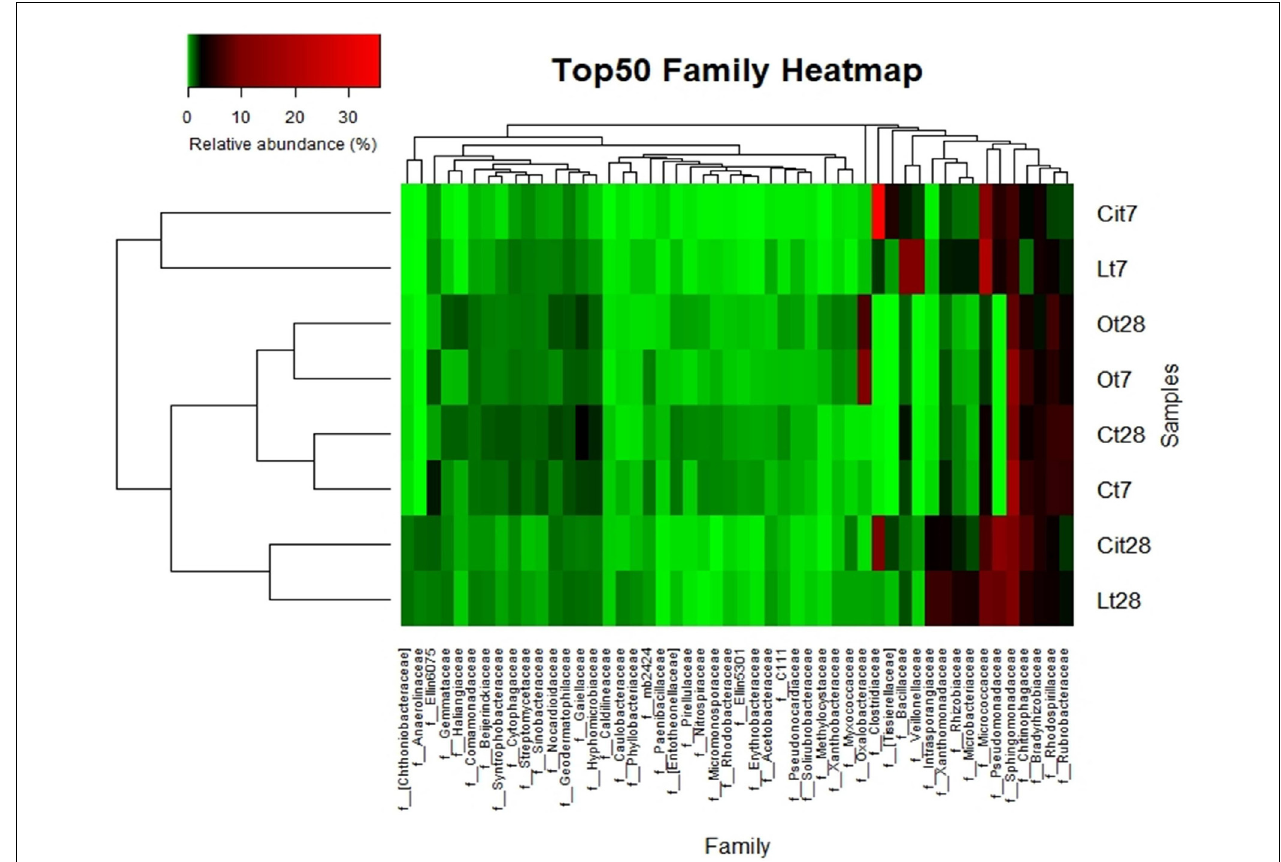
FIGURE 9 | Top 50 most-abundant identified bacterial families. Double hierarchical dendogram of bacterial distribution. Average linkage hierarchical clustering based on Bray–Curtis dissimilarity. C, control sample; L, lactic acid treated sample; O, oxalic acid treated sample; Ci, citric acid treated sample. t7: day 7; t8: day